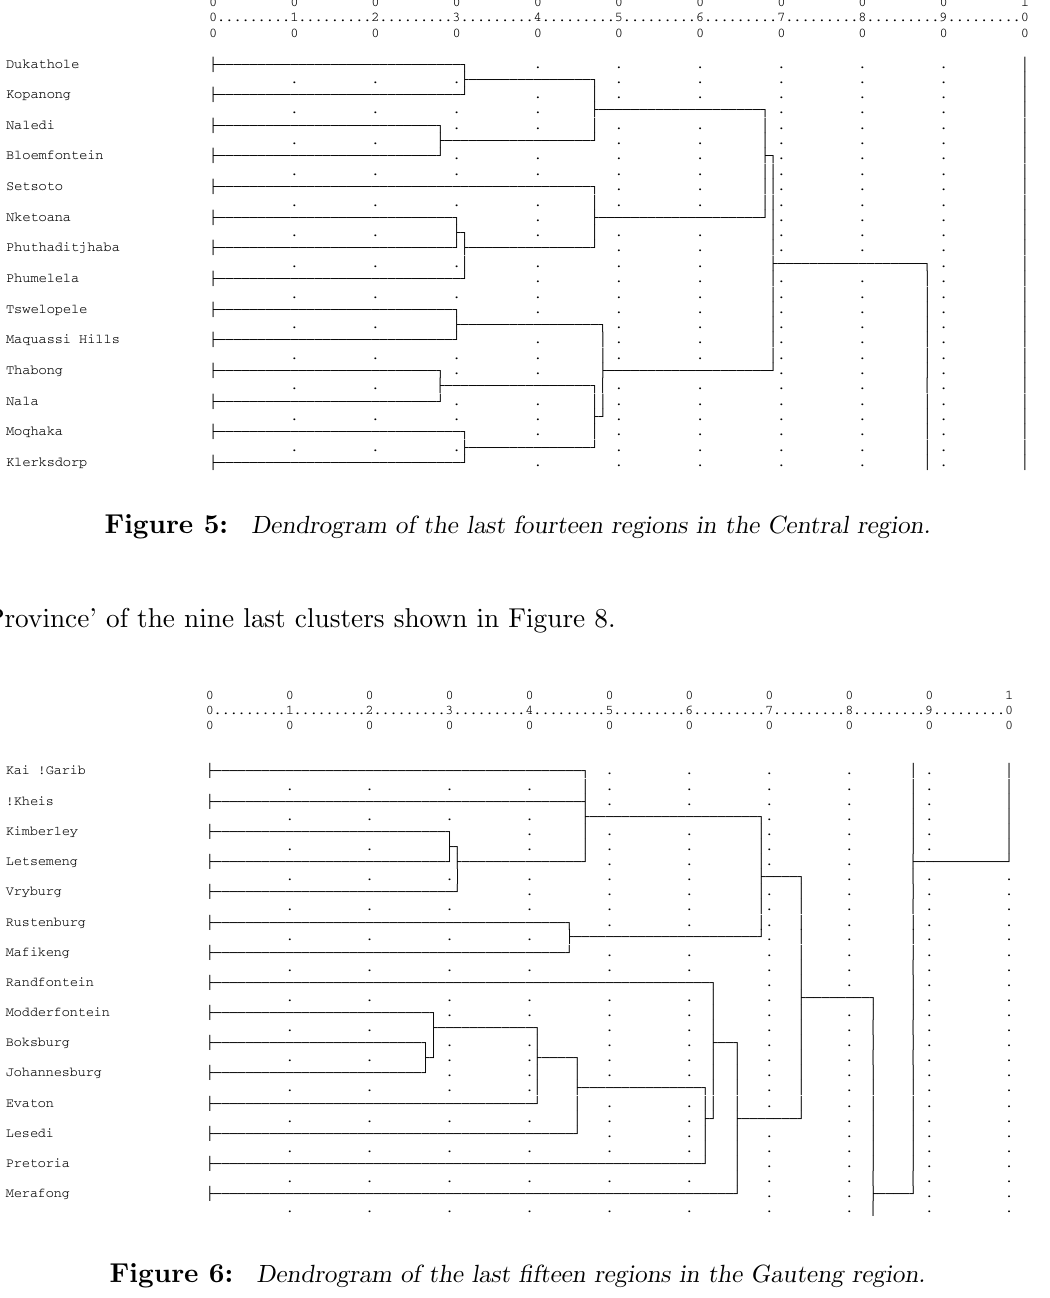
Figure 7 is a fusion of the remaining regions of the Limpopo Province and the Mpumalanga Province. Msukaligwa (Ermelo region) and Mkhondo (Piet Retief region) merge with Embalenhle (Kinross, Leslie, Evander regions) and Witbank region (48% intrazonal). The Highlands (Dullstroom, Machadodorp regions) and Mbombela (Nelspruit region) regions merge with the greater Witbank region (67% intrazonal) which completes the ‘Eighth Province’ of the nine last clusters shown in Figure